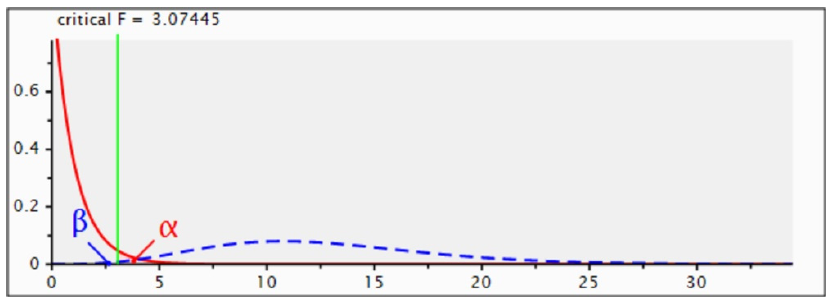
Figure 5. Power Analysis to define the Sample Size Effect.